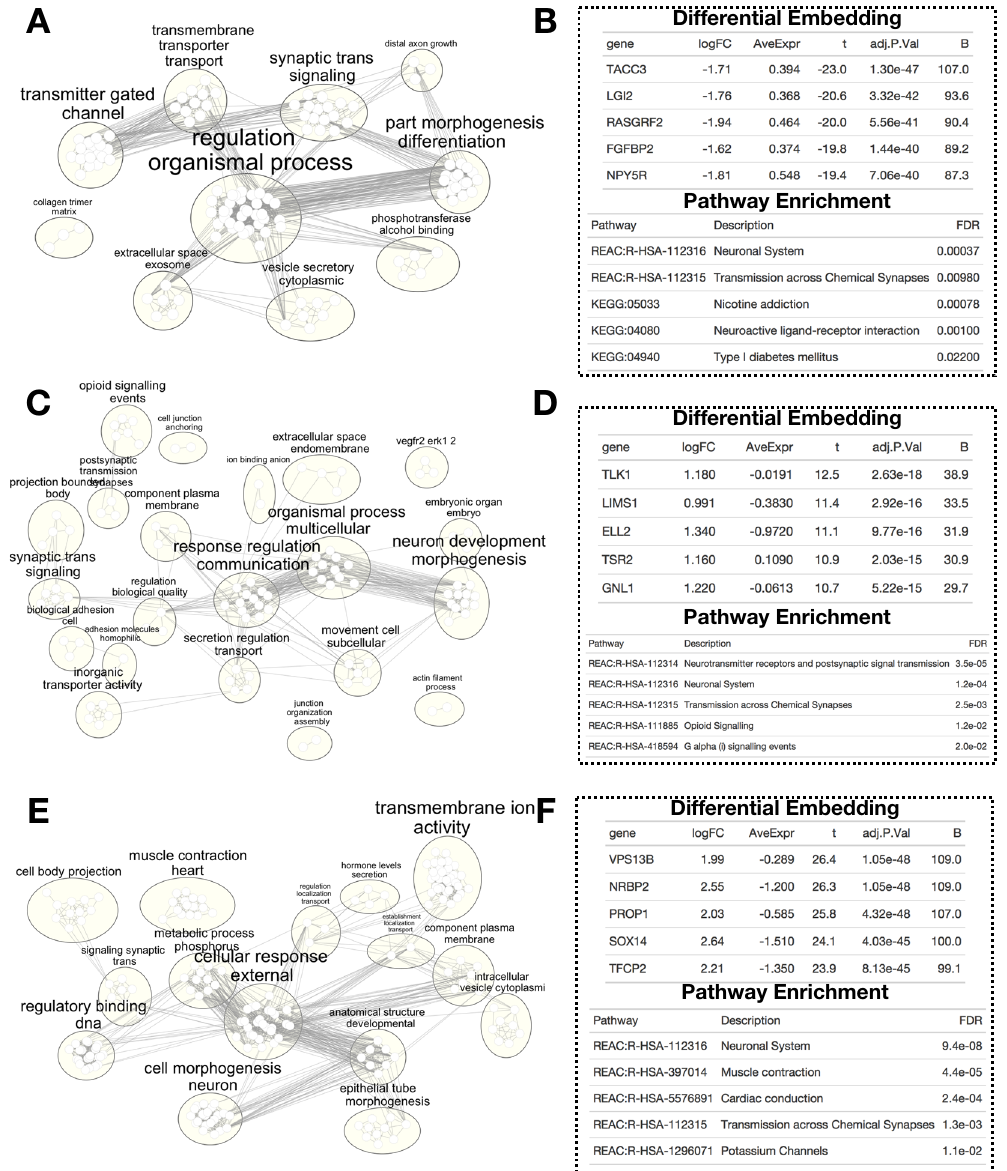
Fig. 3 Example output from pathway enrichment analyses for. A , B GBM-control embeddings, C , D LGG-control embeddings, and E , F MB- control embeddings; left-side plots: correspond to summaries of GO/KEGG/Reactome enrichments using EnrichmentMap in Cytoscape, plotted via RCy3; each small node corresponds to a pathway; node; and text size proportional to the number of overlapping genes after differential gene-level embedding analysis; edge between nodes corresponds to shared genes; large ellipses correspond to found clusters using Markov chain clustering, three words extracted to annotate cluster using a word cloud algorithm; right-side plots: example output of differential embedding ( limma ) and pathway enrichment analyses (g:Pro fi ler) on embeddings; top fi ve genes and select pathways listed of the many uncovered in each